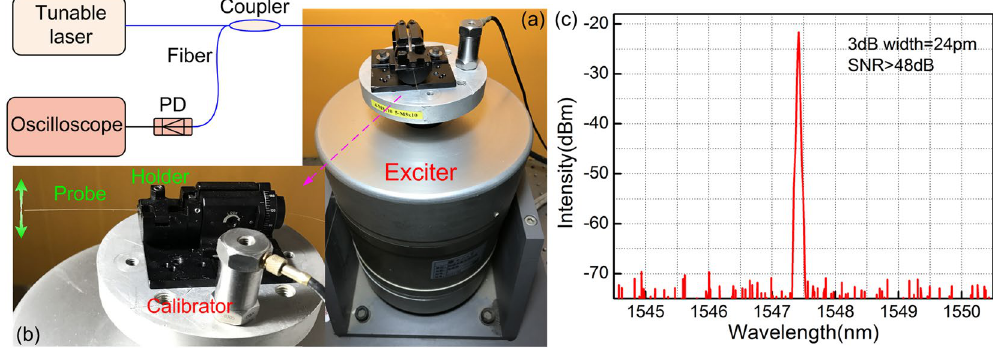
Figure 4. ( a ) Schematic of the acceleration sensing system, ( b ) magnified view of the DCF-FBG sensing probe and the acceleration calibrator, and ( c ) reflection spectrum as laser is fixed at the fundamental mode position.